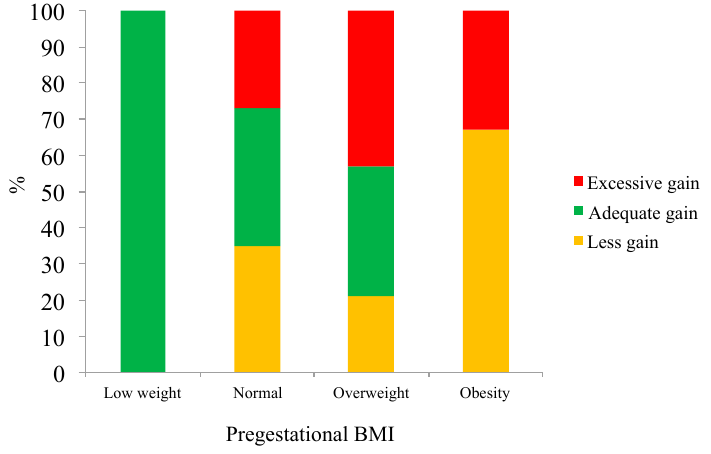
Figure 1. Gestational weight gain (%) according to pregestational BMI.